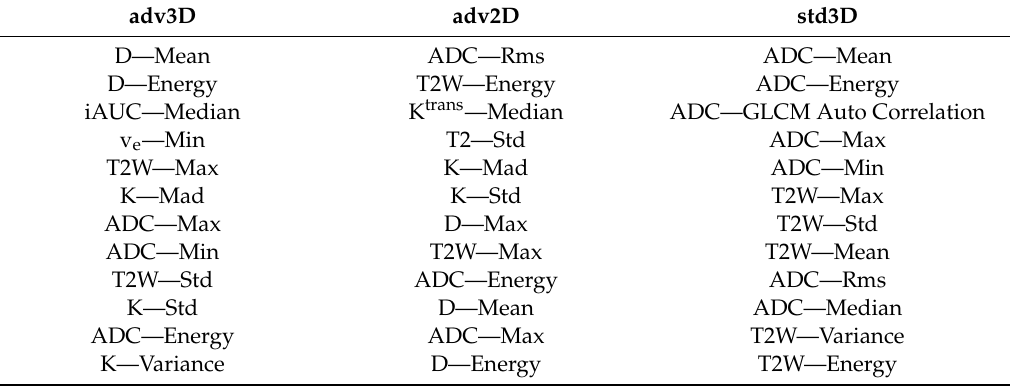
Table 1. Reduced feature set for each classification task. For each feature, the image from which it was extracted is indicated. For std3D, whether it is a first or second order feature and the feature name are also indicated. Abbreviations: T2W = T2-weighted; ADC = Apparent Di ff usion Coe ffi cient; D = di ff usion coe ffi cient of Di ff usion Kurtosis Imaging (DKI) model; K = deviation from normal distribution coe ffi cient; iAUC = initial area under the enhancement curve; v e = volume of extravascular extracellular space per unit volume of tissue; K ep = ; K trans = ; Max = maximum; Mad = mean absolute deviation; Min = minimum; Rms = root mean square; Std = standard deviation; GLCM = Gray Level Co-occurrence